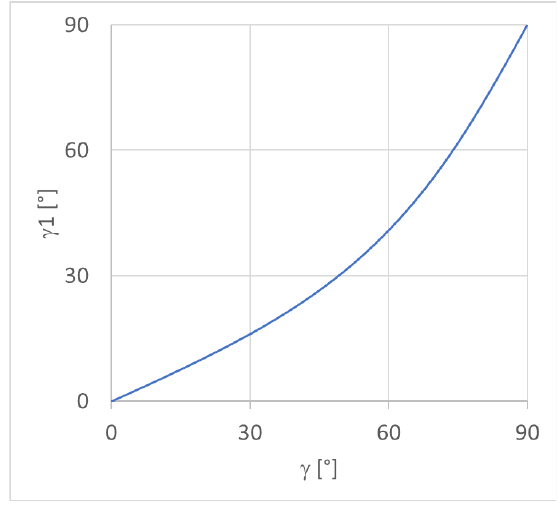
Figure 10. γ 1 vs. γ for lth = 0.2 mm and hs = 0.4 mm.